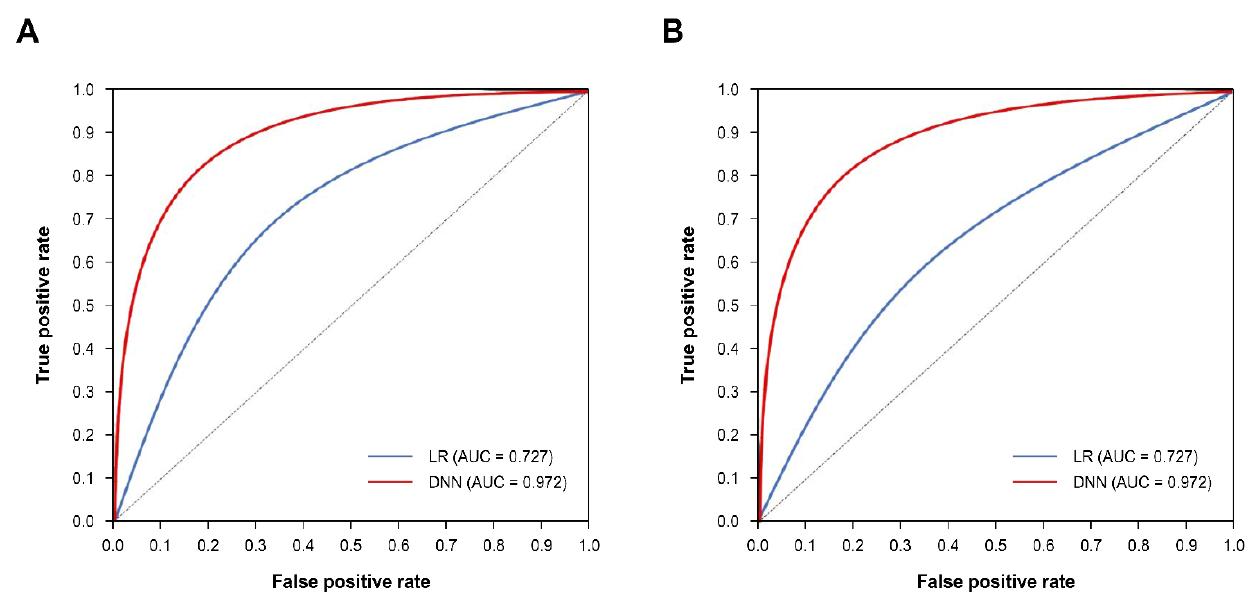
Figure 4. Comparison of ROC curves. ( A ) MI, ( B ) Stroke. AUC; area under the curve. DNN: deep neural network. LR: logistic regression. MI: myocardial infarction. ROC: receiver operating Table 4. Performances of logistic regression and deep neural network models for MI and stroke.